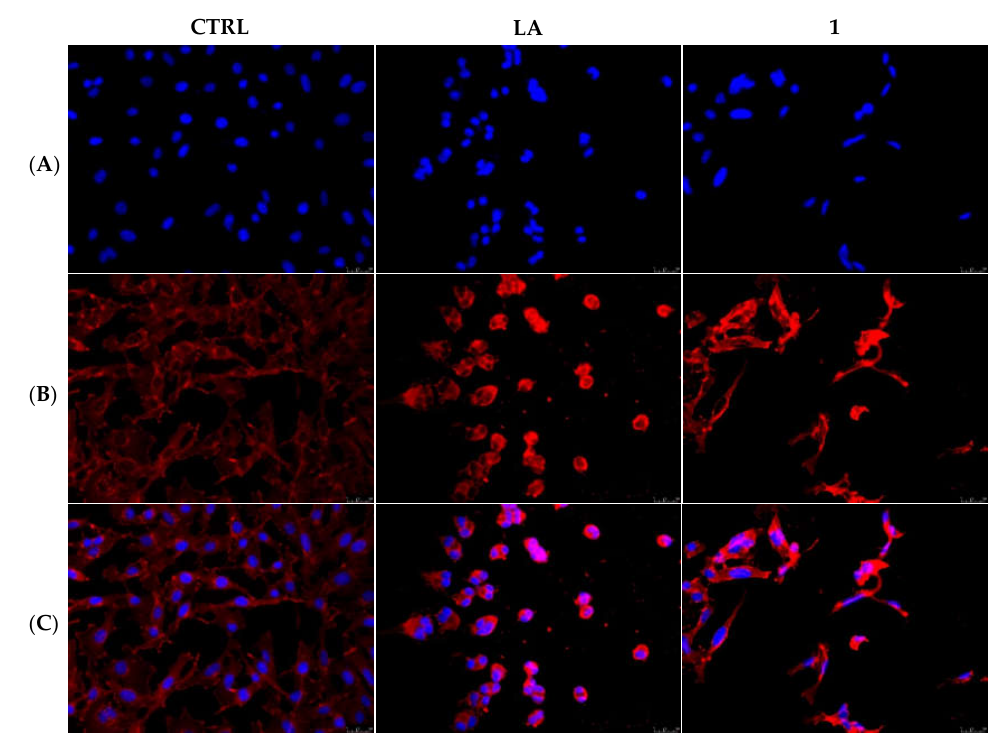
Figure 3. Actin immunofluorescence studies. MDA-MB-231 cells were exposed to compound 1 (used at its IC 50 value), with 0.1 μM Latrunculin A (LA) or with a vehicle (CTRL) for 24 h. Then the cells were further processed, observed and imaged under the inverted fluorescence microscope at 40x magnification. CTRL cells showed a regular arrangement and organization of the actin cytoskeleton. MDA-MB-231 cells exposed to LA and, as well as those treated with compound 1 , exerted an irregular arrangement and organization of the actin system. Panels ( A ): nuclear stain with DAPI ( λ ex / λ em = 350/460 nm); Panels ( B ): β -actin (Alexa Fluor ® 568; λ ex / λ em = 644/665 nm); Panels ( C ): show a merge. Representative fields are